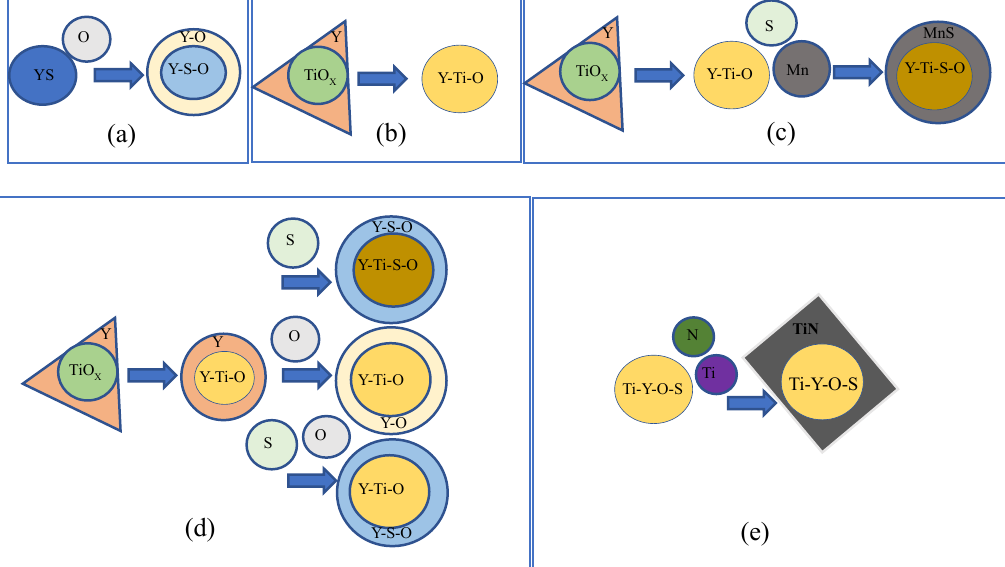
Figure 4. Schematic of the evolution of various inclusions in the experimental steel alloys. ( a ) Y-S-O; ( b ) Y-Ti-O; ( c ) Y-Ti-Mn-S-O; ( d ) Y-Ti-S-O; ( e ) Y-Ti-O-S-N .